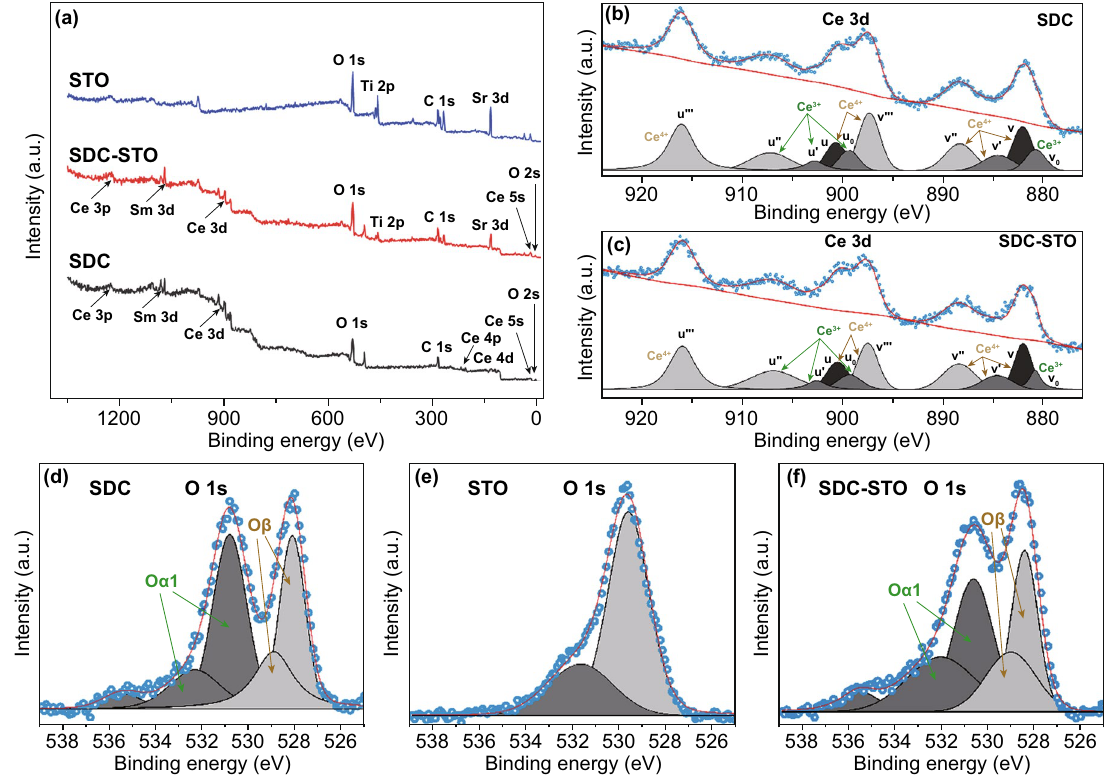
Fig. 3 XPS results for the SDC, STO, and 4SDC–6STO samples: a survey spectra, b, c Ce 3d core-level spectra, and d - f O 1s core-level